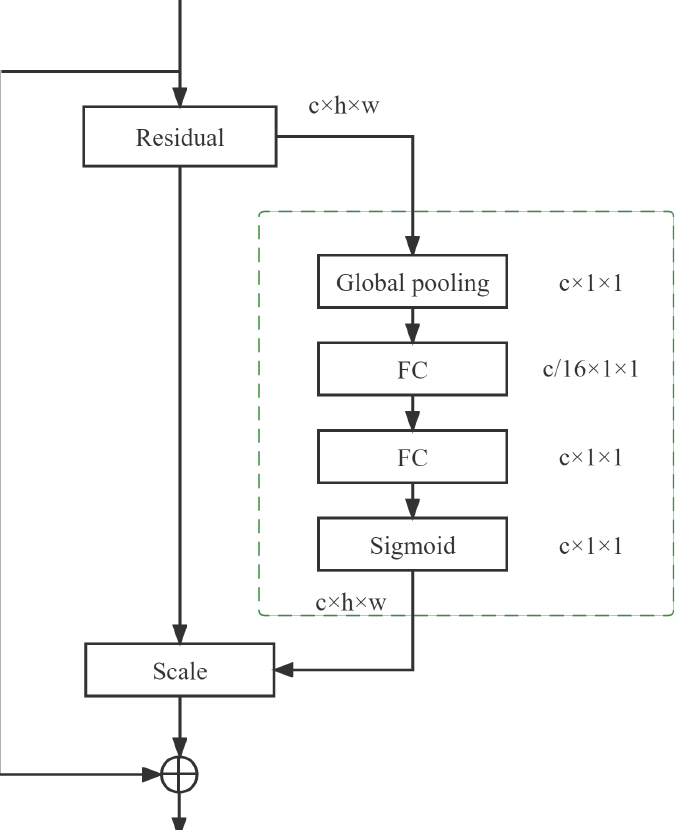
Figure 4. Residual networks under SENet attention